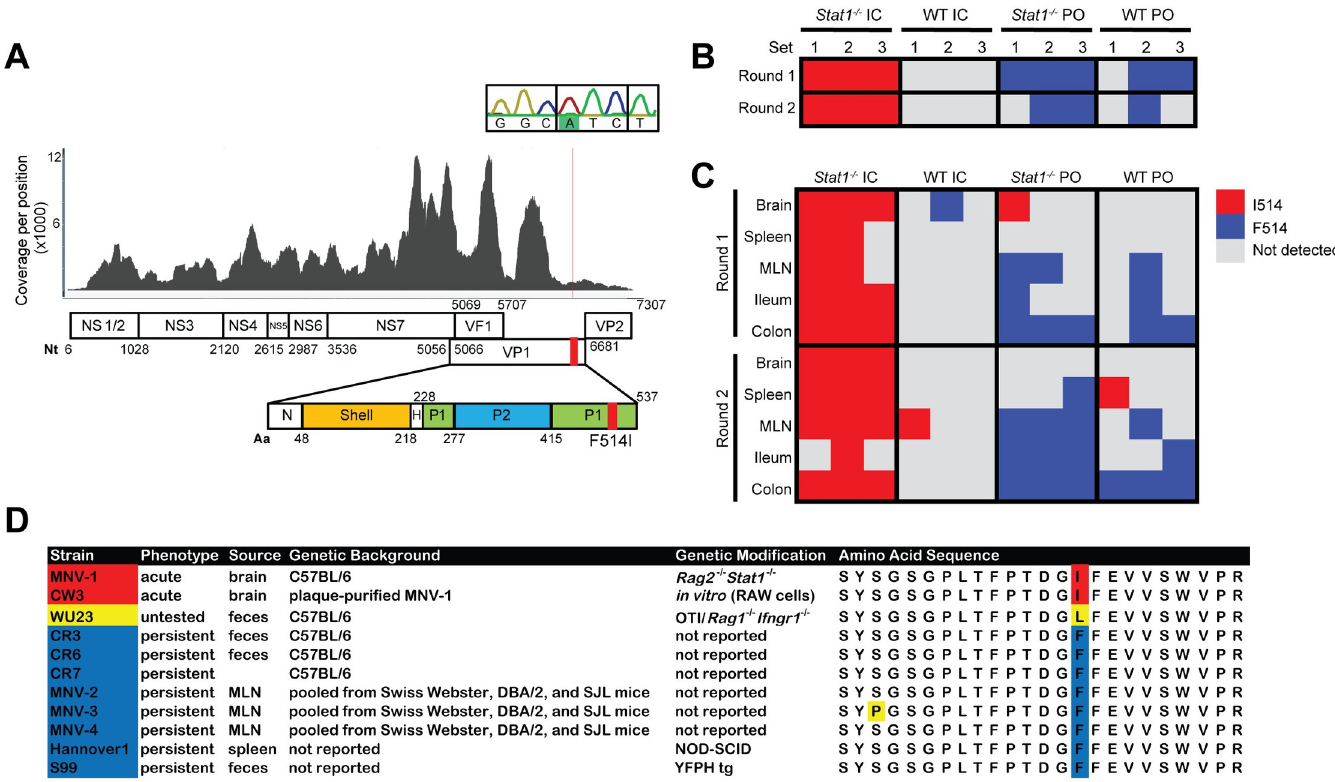
Fig 2. Amino acid change F514I is observed in Stat1 -/- IC samples and in virulent MNoV strains. (A) Alignment of “Set 1, Round 2” stool Illumina sequencing reads to the CR6 genome was performed and visualized using an in-house pipeline, with the position 6595 mutation from the reference designated by a red line. Nucleotide (nt) positions along the MNoV genome are depicted along the open reading frames encoding viral proteins. Amino acid (aa) positions for the VP1 protein are depicted below the genome, including N-terminal arm (N) and hinge (H) regions in addition to the shell, P1, and P2 domains. Sanger sequencing-based confirmation of T6595A, encoding F514I, was also performed and is shown in the inset box, with the codon for this amino acid outlined. (B,C) Heatmap of Sanger sequencing-based analysis of position 6595 of indicated stools (B) and tissues (C) at time of death as depicted in Fig 1B , with resulting encoded amino acid depicted by color; “not detected” indicates that sequencing was insufficient across this position to call the base. (D) Alignment of a subset of VP1 amino acids (positions 500–523) for persistent and acute murine norovirus strains, with position 514 highlighted.